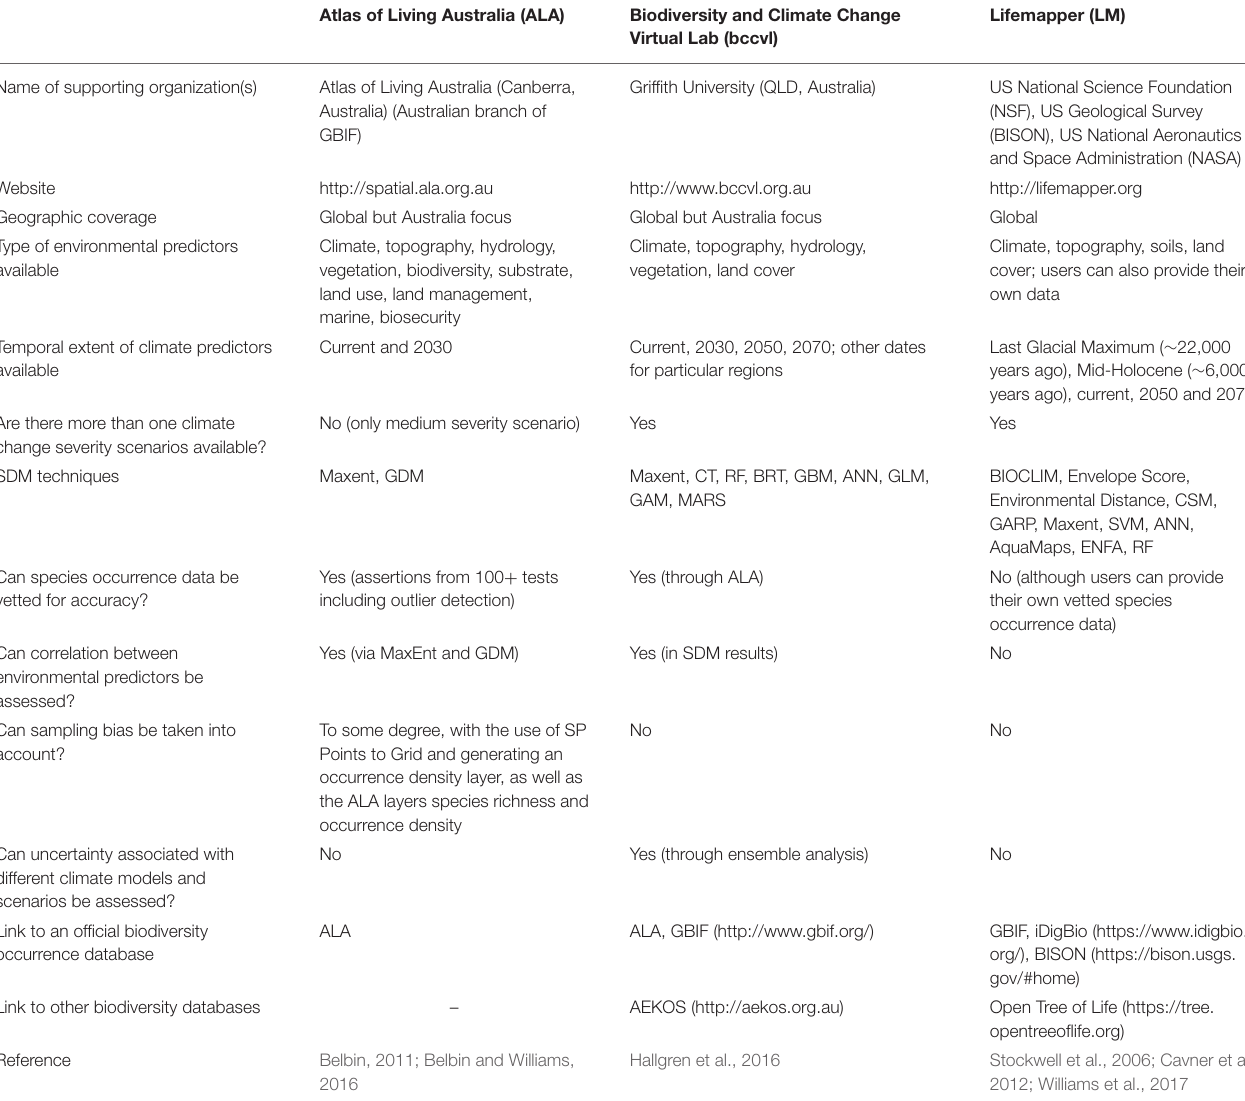
TABLE 1 | Examples of web-based GIS interfaces that embed SDM